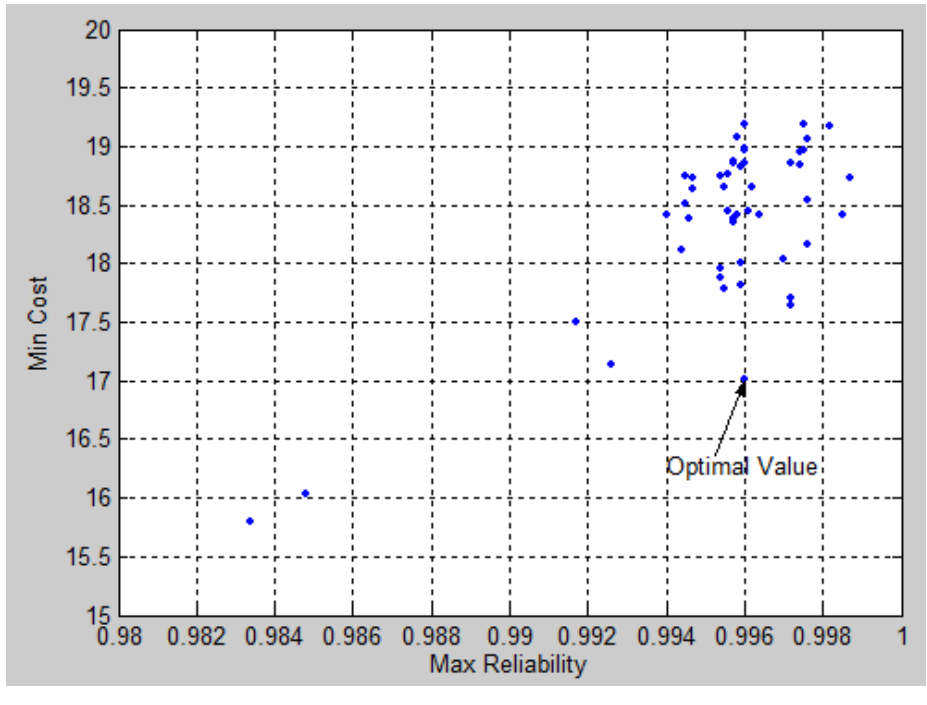
Figure 4. Pareto front of Example 2. Table 6. Optimal design configurations for multi-objective optimization (second problem). Multi-Objective